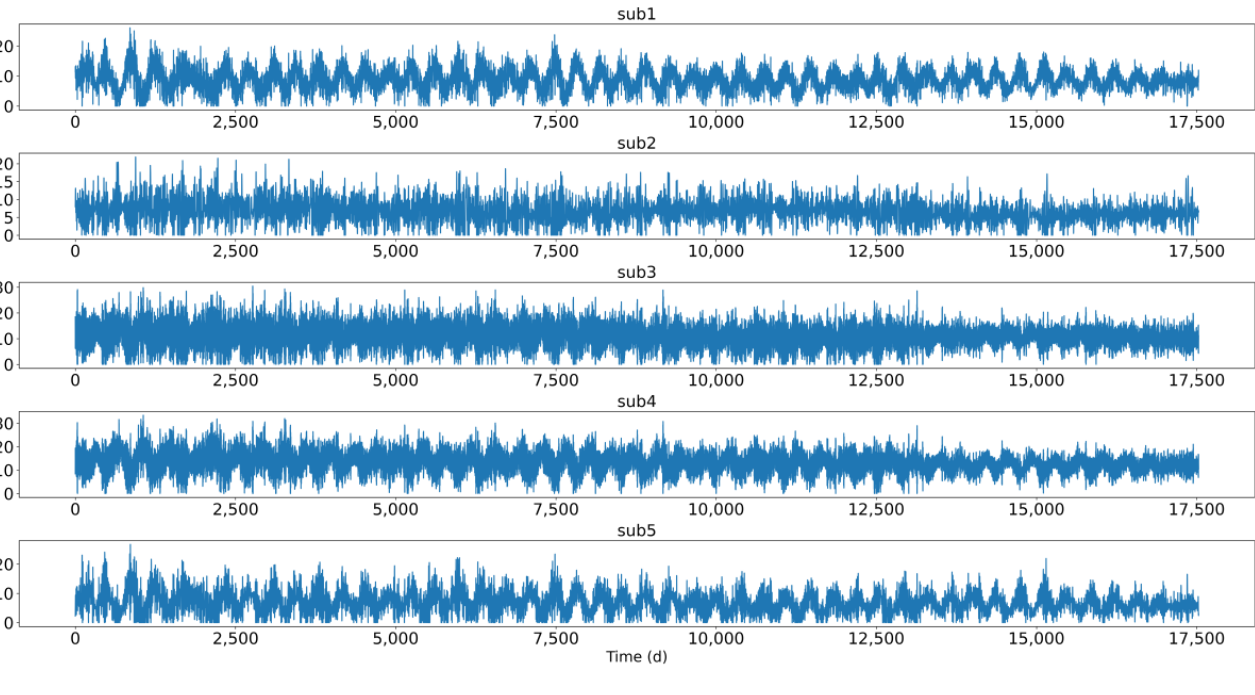
Figure 8. The five subfigures represent five subsequences which are generated through decomposition